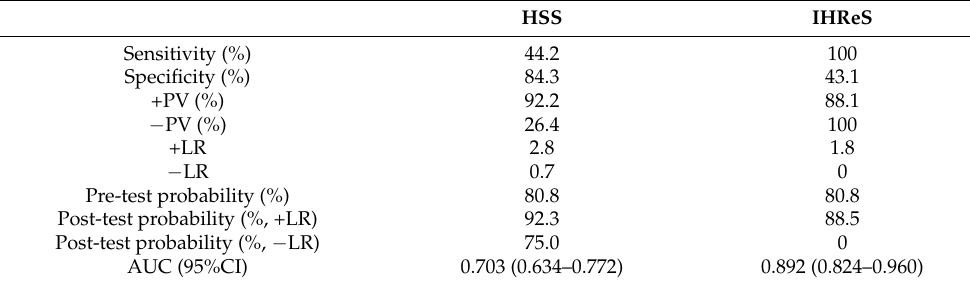
Table 2. Statistical parameters for the studied clinical measures of the HSS and IHReS.